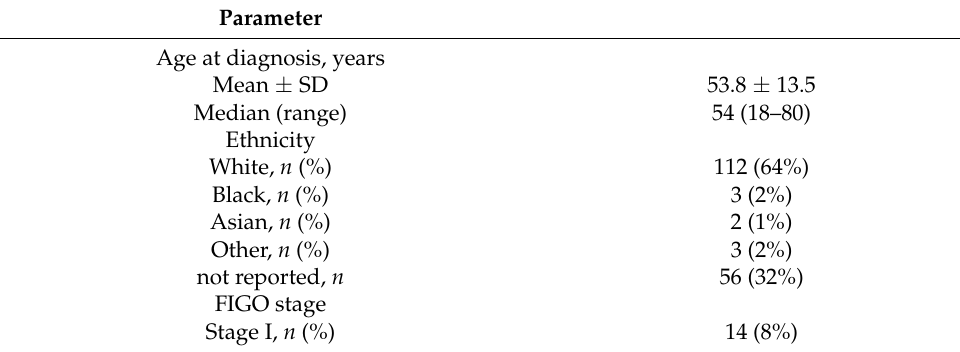
Table 1. Demographic and clinical